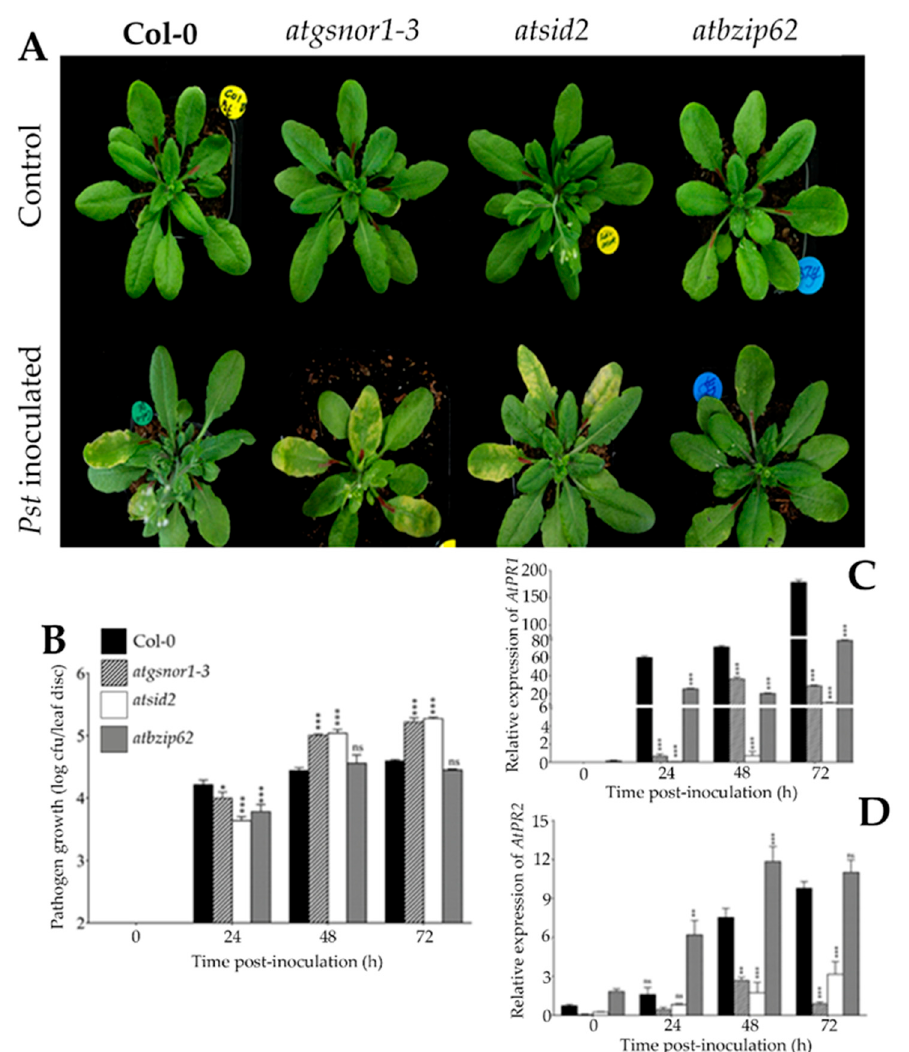
Figure 1. AtbZIP62 negatively regulates basal defense. ( A ) Phenotypic response of Arabidopsis genotypes (Col-0 WT, atgsnor1-3 , atsid2 , and atbzip62 ) challenged with Pseudomonas syringae pv. tomato ( Pst ) DC3000 infection; ( B ) growth pattern over time of Pst DC3000 vir in tested genotypes; ( C ) expression level over time of AtPR1 ; ( D ) expression level over time of AtPR2 in response to Pst DC3000 vir . The phenotypes were recorded at 9 dpi, and leaf samples for gene expression analysis were collected over time (0, 24, 48, and 72 hpi) in triplicate. To confirm the phenotype, the experiments were repeated four times. * p < 0.05; ** p < 0.01; *** p < 0.001; ns, nonsignificant.